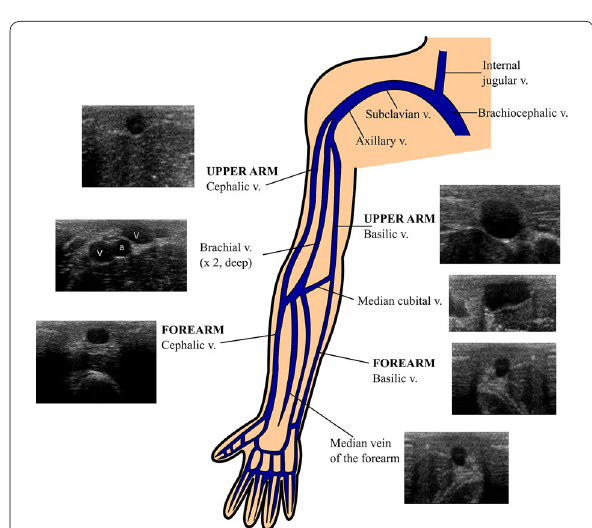
Fig. 3 Anatomy of the peripheral veins of the upper limbs. v vein